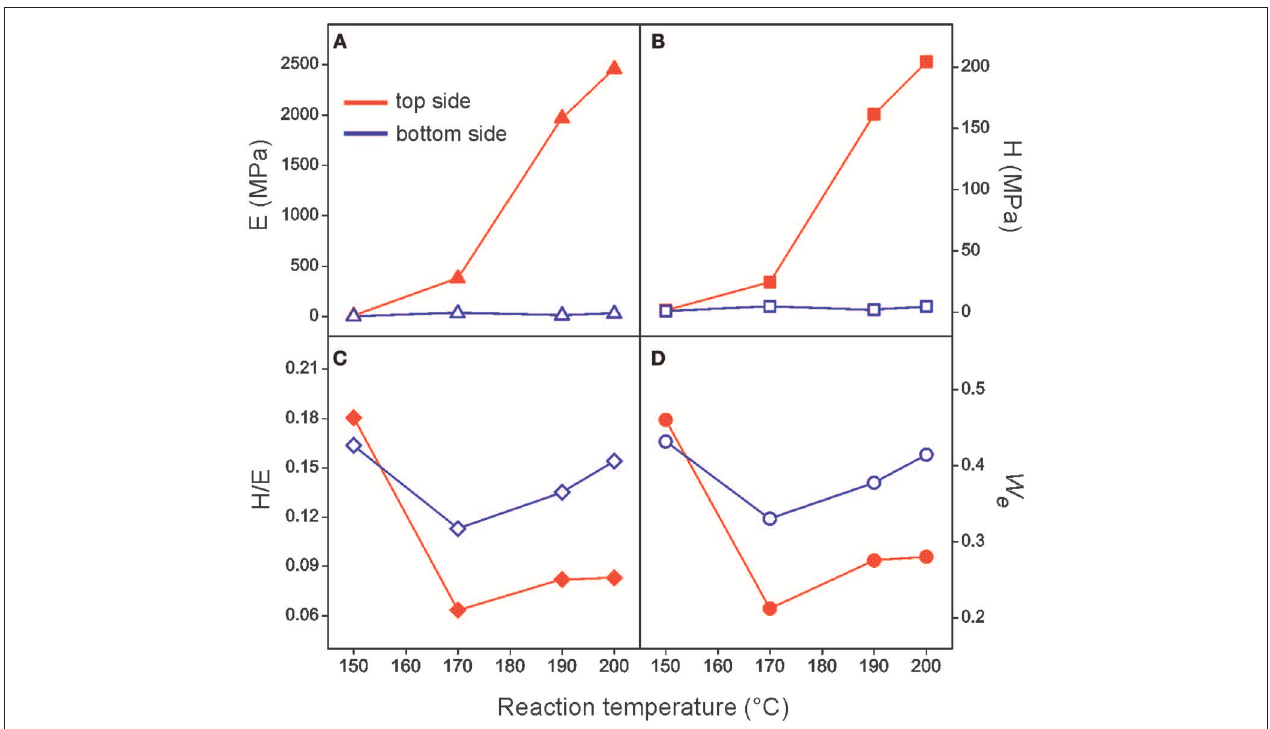
FIGURE 7 | Indentation parameters: (A) E, elastic modulus, (B) H, hardness, (C) H/E, elastic strain to failure, and (D) W e , elastic recovery for the air exposed (top) and the air preserved (bottom) sides of polyaleuritate films synthesized in air for 22h at the indicated